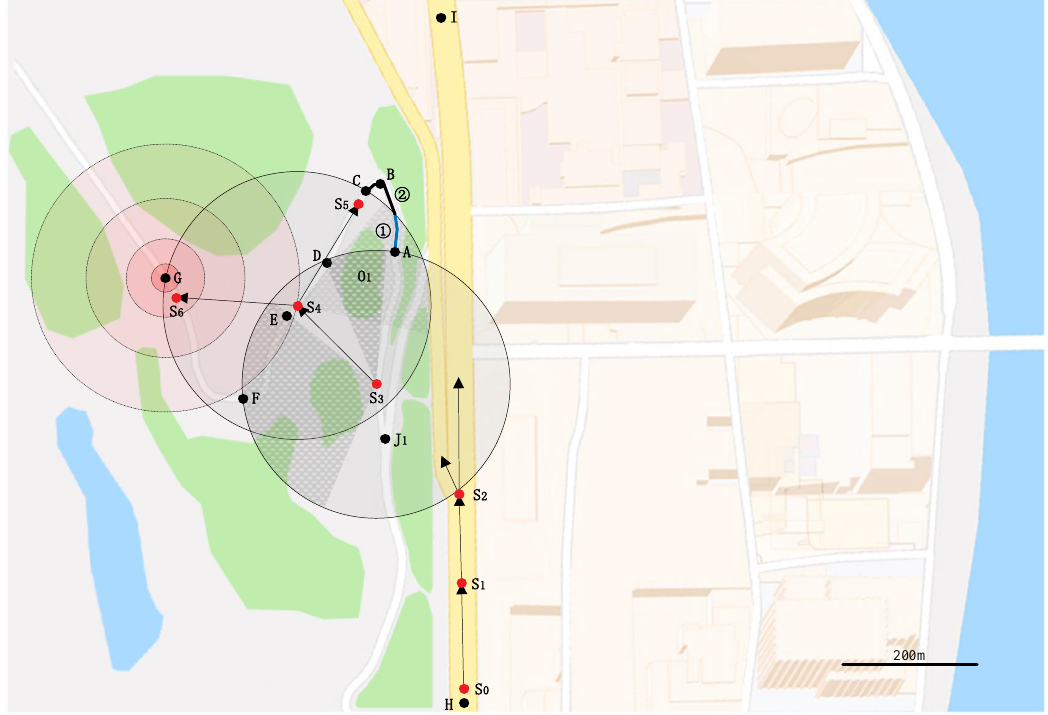
Figure 1. Relay-node selection in the Region of Interest (RoI).